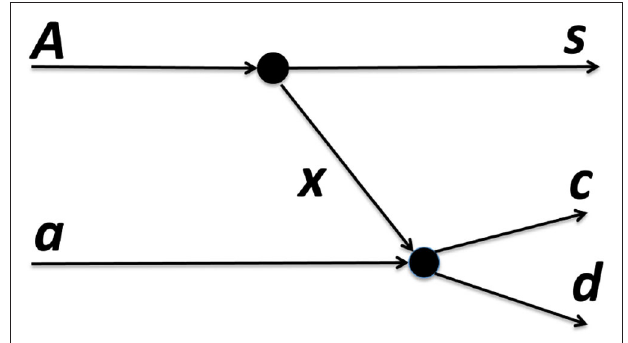
FIGURE 1 | The quasi-free (QF) a + A → c + d + s reaction described by a pole diagram (see text for details). The upper pole represents the breakup of the nucleus A into its cluster x and s . In this description, the x nucleus is called participant of the binary reaction a ( x , c ) d (lower pole), while the s particle flies away without taking part to the reaction ( spectator